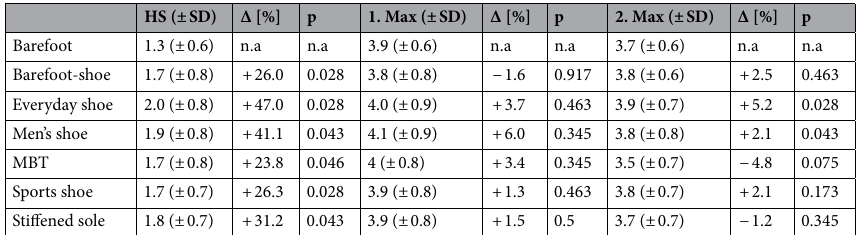
Table 3. Deltas [%] of the bending moment M bend in relation to barefoot walking at 4 km/h; HS heel strike, SD standard deviation, MBT Masai-Barefoot-Technology.